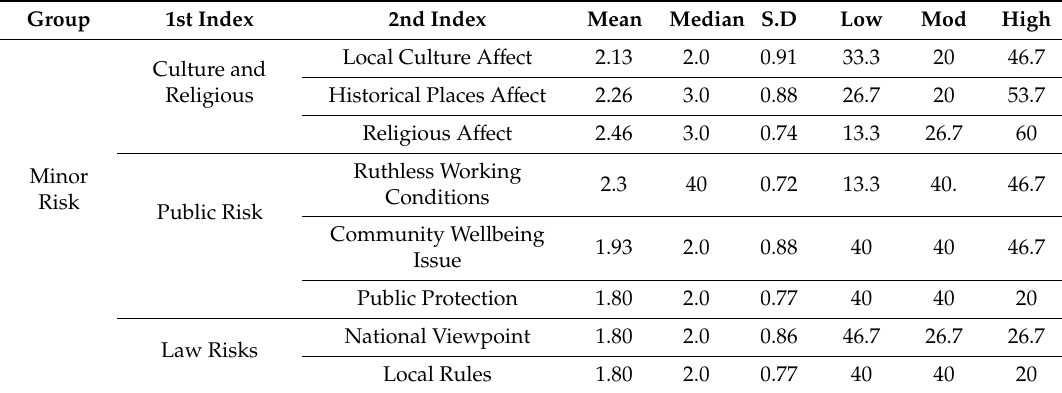
Table 8. Minor-level risk for round